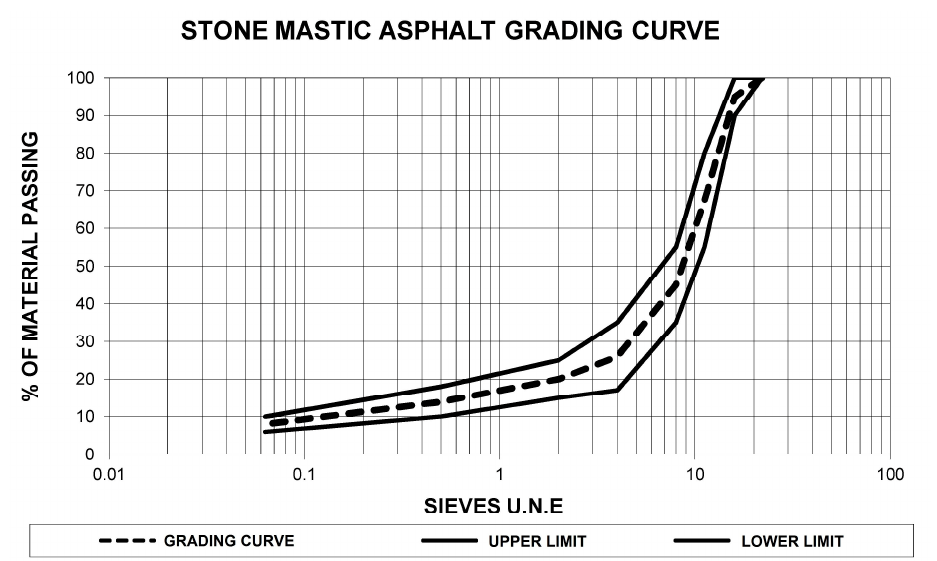
Figure 1. Grading curve of the different families of bituminous mixtures (ACFC, ASFC and ASFC) type SMA.